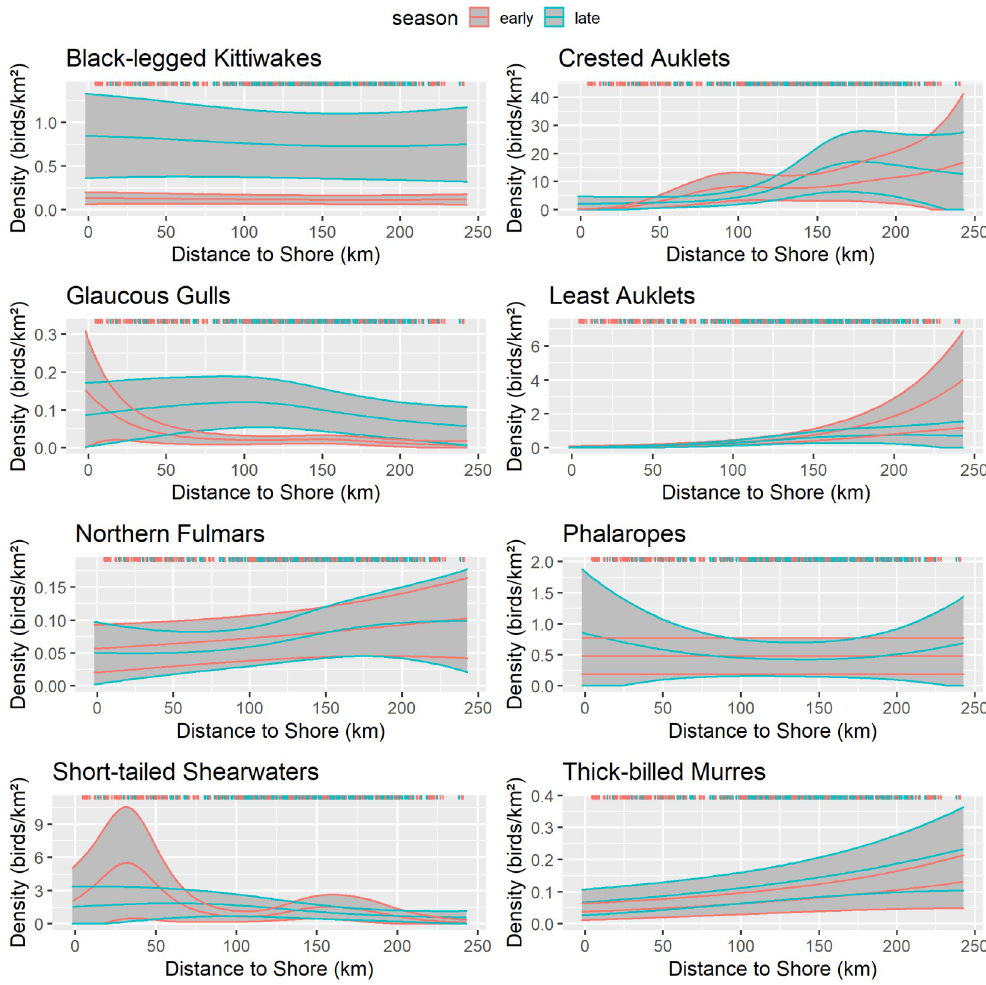
Fig 11. Effect of distance to shore on seabird density, northeastern Chukchi Sea, 2008–2018. Response curves are from the best-fitting generalized additive model. Solid lines represent the smooth function and 95% confidence limits for early summer(pink) and late summer(aqua). Gray shading indicates the 95% confidence intervals. Colored ticks indicate the distribution of